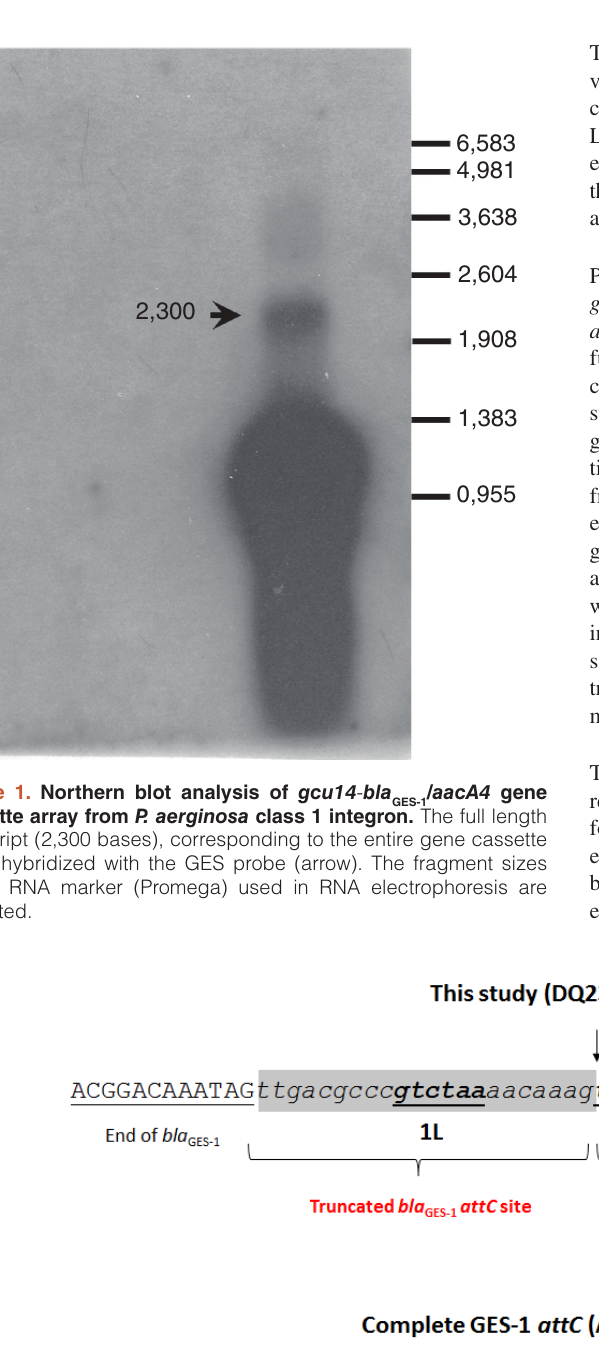
Figure 2. Sequences of the canonical (AF355189) and the truncated (this study) GES-1 attC sites. The underlined uppercase letters represent the bla and aacA4 partial coding regions. Italicized lowercase letters highlighted in grey define the attC sites, and their core sites GES-1 (1L, 2L, 2R, 1R) are in boldface and underlined. The vertical arrows show the recombination point and the beginning of the next cassette.